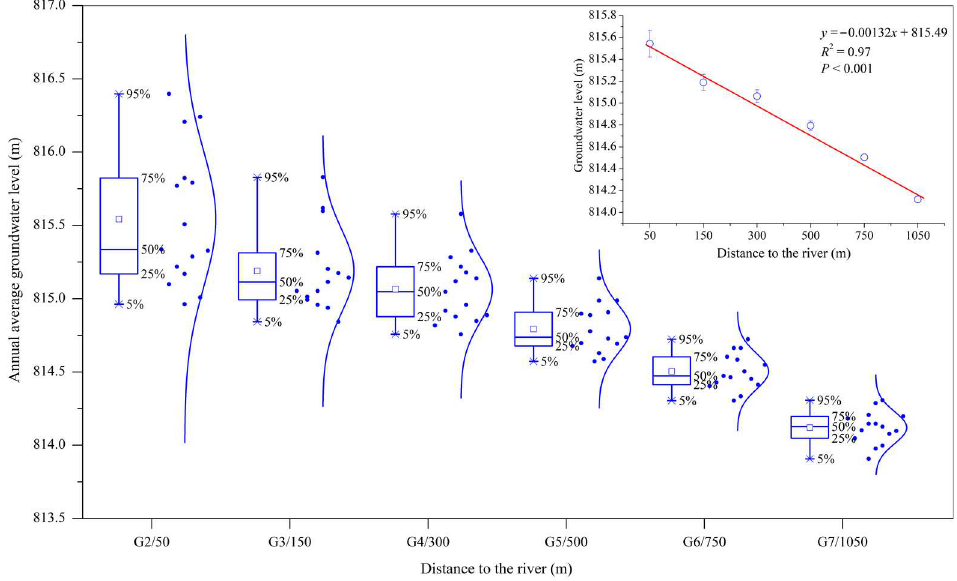
Figure 9. Groundwater levels at different distances to the river (G refers to the name of the groundwater monitoring well; see also Figure 4).